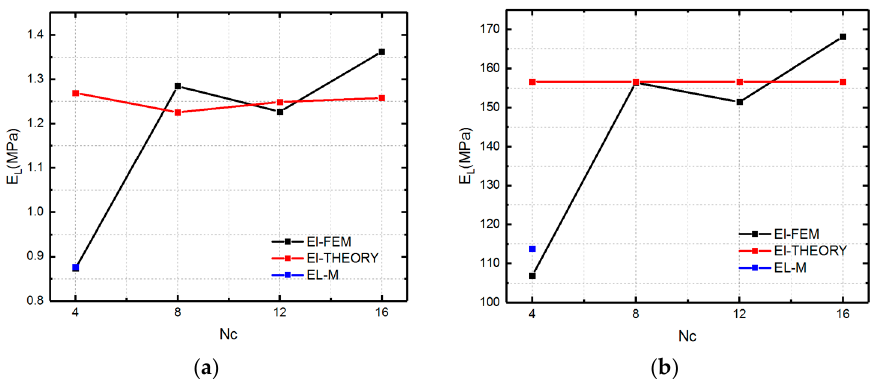
Figure 16. Modulus (El-FEM representing the simulation results of longitudinal modulus of SMP stent, El-THEORY representing the theoretical results of longitudinal modulus of stent and EL-M representing the modified result of longitudinal modulus of stent for Nc = 4) of the SMP stent in the longitudinal direction at two states: ( a ) rubbery state; ( b ) glassy state.